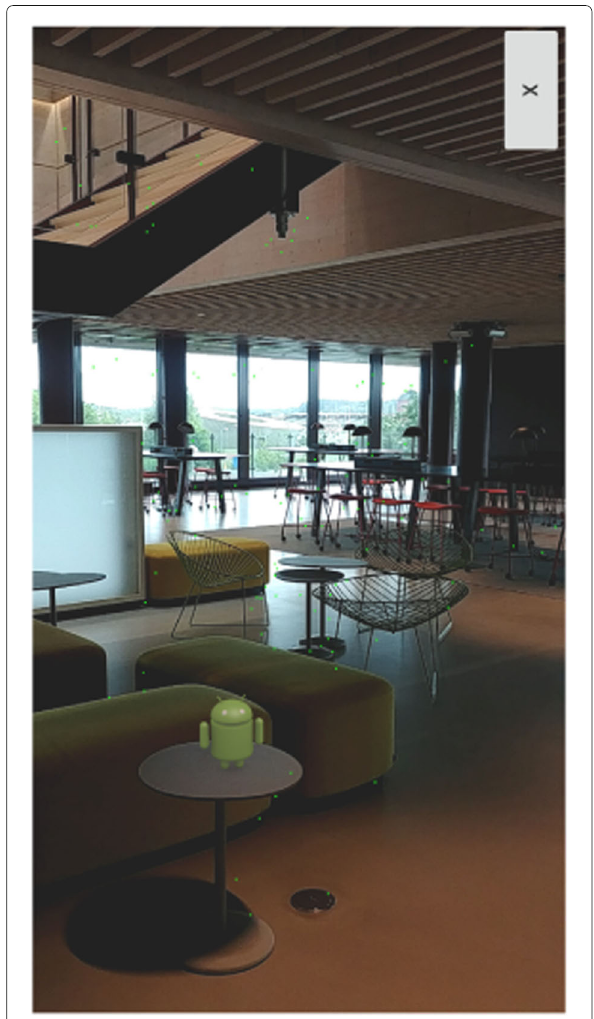
Fig. 1 Example of mixed reality output